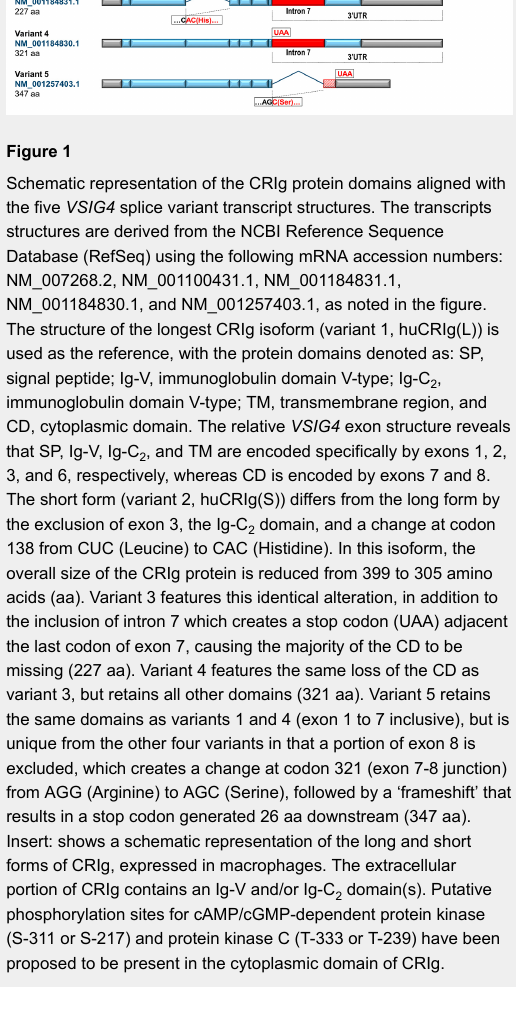
Table 1: Key developments in the field of complement receptor immunoglobulin (CRIg).